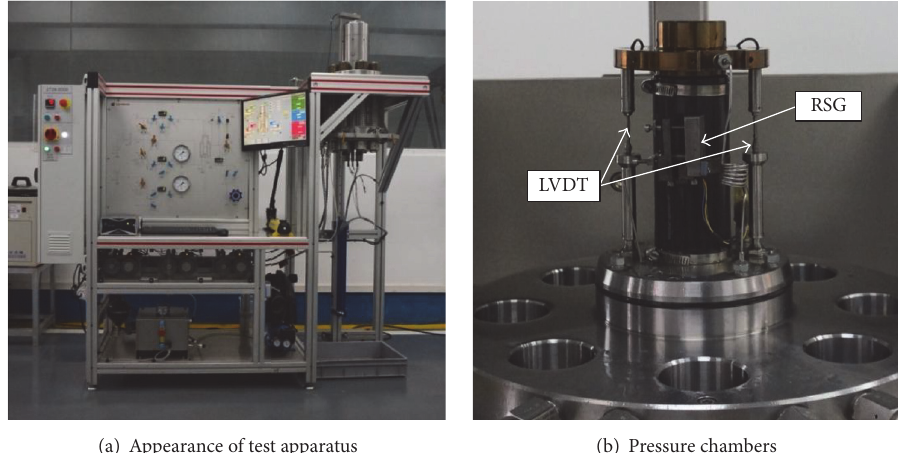
Figure 2: The multifield coupling rock triaxial test apparatus.